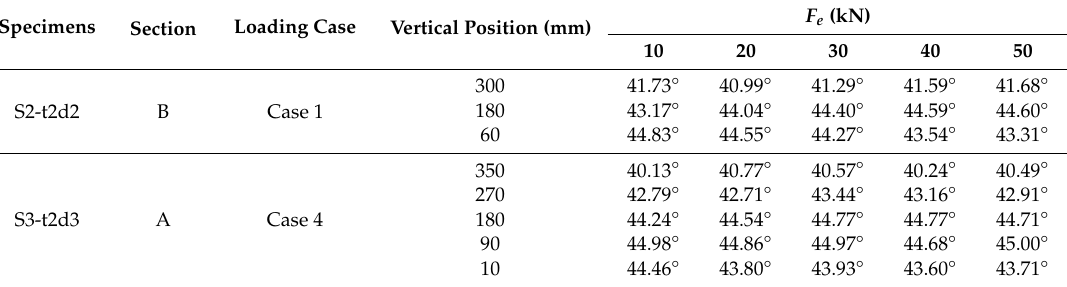
Figure 12. Shear strain distributions of CSWs for specimen S3-t2d3: ( a ) A section; ( b ) B section. Table 12. Principle strain direction angles of CSWs.